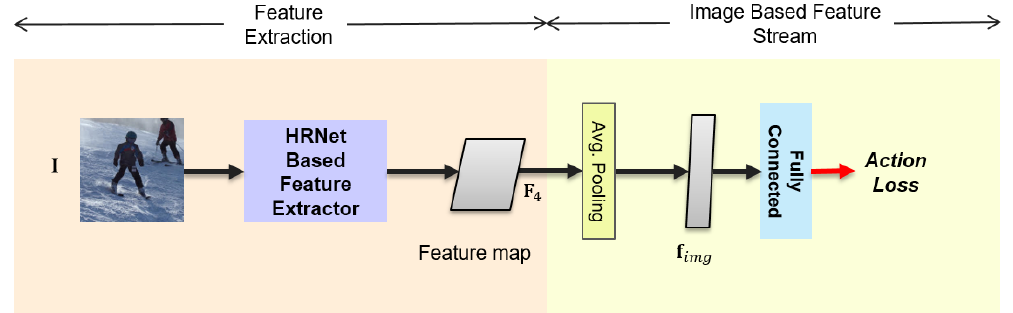
Figure 2. Image-based feature stream. The figure depicts the shared HRNet-based feature extractor and image-based feature stream depicted in Figure 1. The background colors are the same as Figure